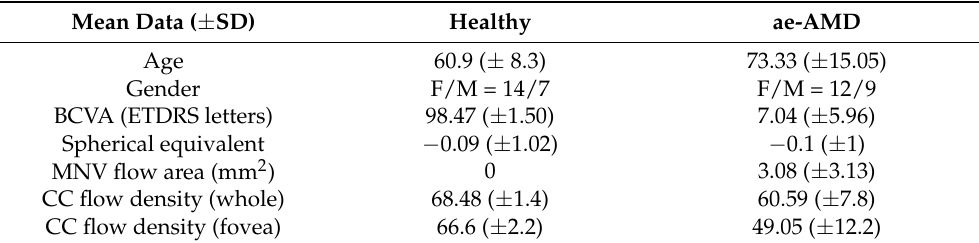
Table 1. Demographic and ophthalmic characteristic of healthy and ae-AMD